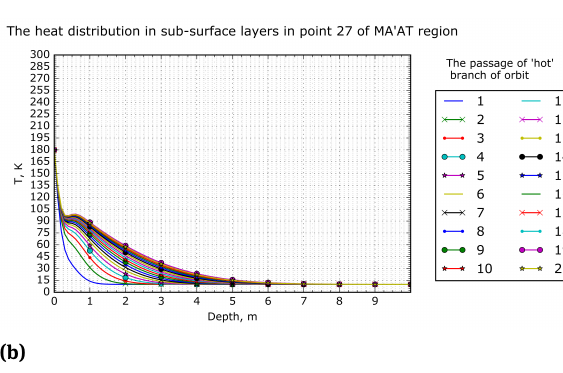
ment, the heating region of subsurface layers in the point 364 of MA’AT region spread to values of 7.0 m, and the max- imum of internal temperatures 107 K was at the level of 0.35–0.45 m. At the "hot" segment of the orbit maximum temperature achieved at the surface (Figure